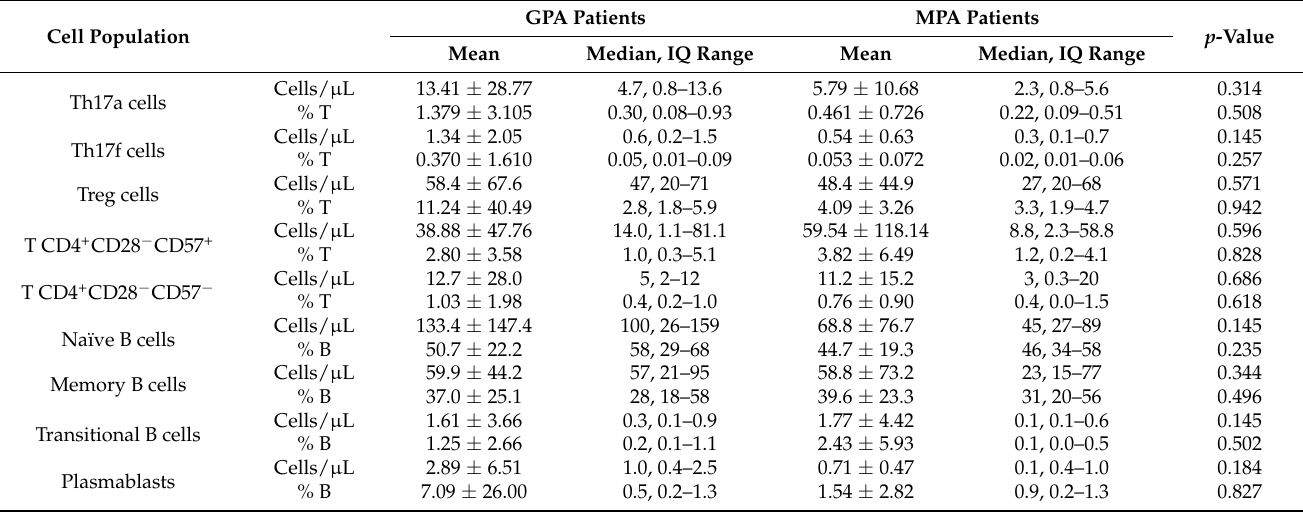
Table 5. T and B cell subsets in the GPA and MPA